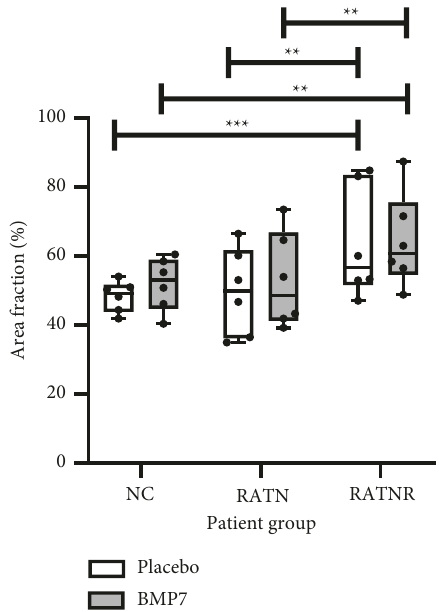
Figure 5: Percentage area fraction taken up by the triple culture cells in the field of view, comparing the cultures exposed to serum from healthy control, treatment-na¨ıve, and treatment-non- responding RA patients, with or without BMP-7 treatment (750ng/ ml). n � 6. Statistical analysis: two-way ANOVA with Tukey’s multiple comparisons. ∗∗ � p < 0 . 01; ∗∗∗ � p < 0 . 001. Data repre- sented as box and whisker plots indicating the highest and lowest 200 µm values, and the median and the interquartile range, as well as individual data